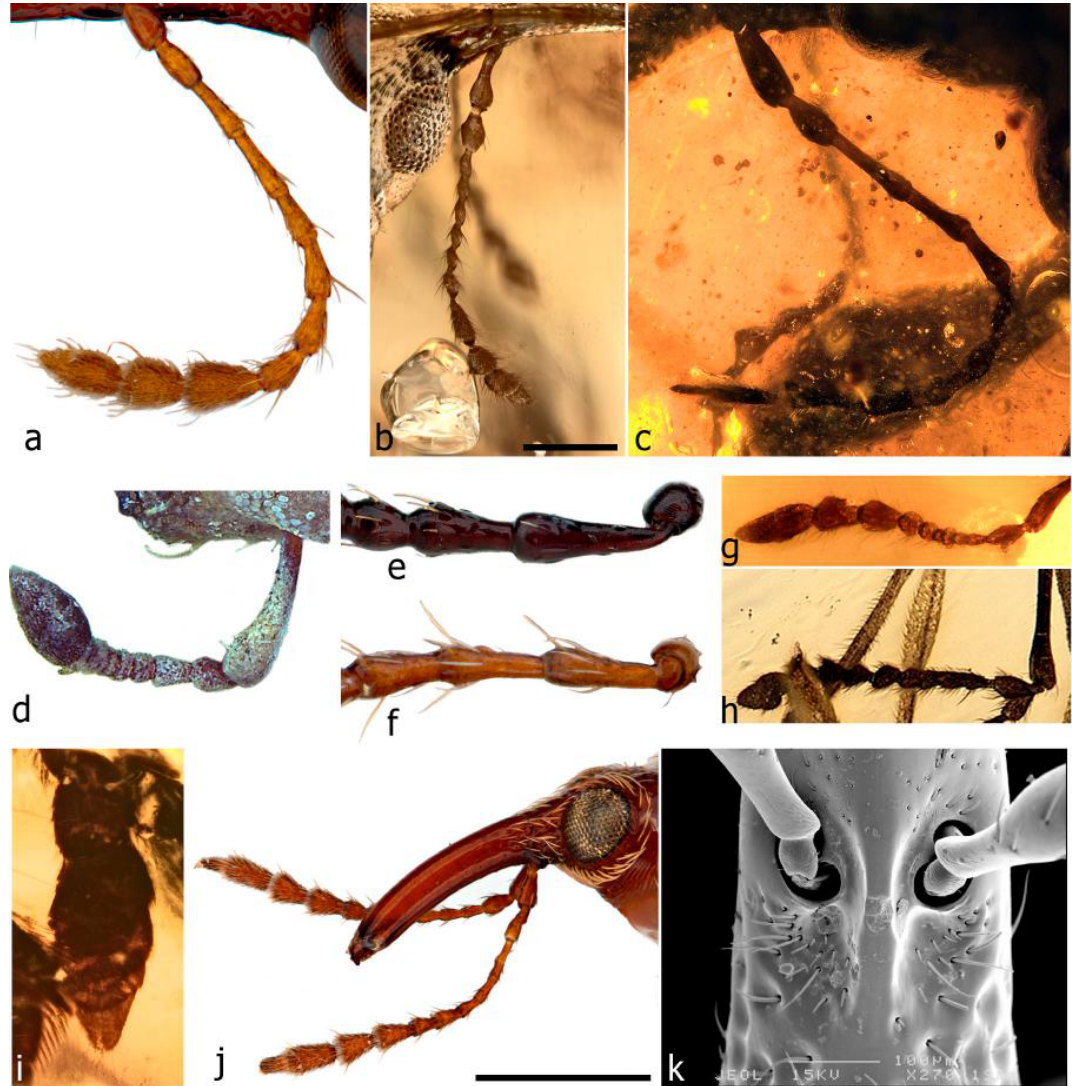
Figure 5. Structure of antennae in extant and Burmese amber weevils. Straight antenna, Rhodocyrtus cribripennis (Attelabidae), dorsolateral view ( a ); subgeniculate antenna, Acalyptopygus brevicornis (Mesophyletidae), dorsolateral view ( b ); subgeniculate antenna, Platychirus beloides (Mesophyletidae), dorsolateral view ( c ); geniculate antenna with compact club, Byrsops deformis (Curculionidae), dorsal view ( d ); ventral scape-pedicel articulation, Tournotaris granulipennis (Curculionidae), apical view ( e ); apical scape-pedicel articulation, Ctenomerus sp. (Nanophyinae), apical view ( f ); geniculate antenna, Bowangius cyclops (Mesophyletidae) ( g ); geniculate antenna, Habropezus crenulatus (Mesophyletidae), ( h ); subcompact antennal club, Petalotarsus oxycorynoides (Mesophyletidae) ( i ); ventrally inserted antennae, Car pini (Caridae), lateral view ( j ); reniform ventral antennal insertion sockets without scrobes, Car cf. condensatus (Caridae) ( k ). Scale bars: 0.2 mm (b); 0.5 mm (j).